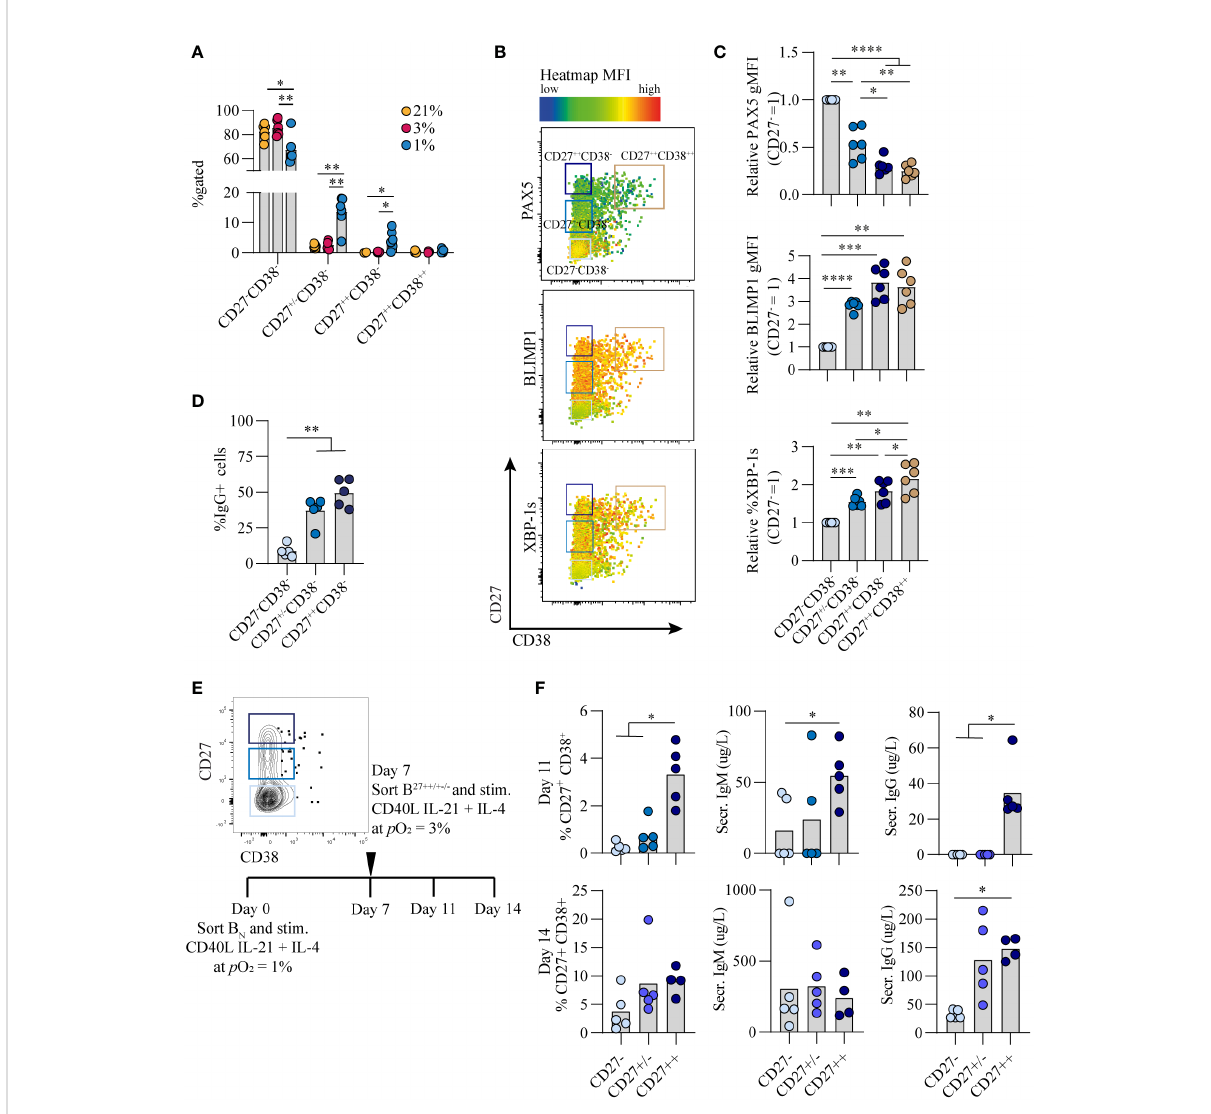
FIGURE 4 Hypoxic p O 2 drives generation of a unique CD27 ++ B cell population, with enhanced antibody secreting cell differentiation capacity and Ig production upon restimulation (A) Quanti fi cation of percentage of CD27 - CD38 - , CD27 +/- CD38 - , CD27 ++ CD38 - and CD27 ++ CD38 ++ cells on day 7 of culture ( n = 5) (B) Representative biaxial fl ow cytometry plot of CD27 and CD38 expression, with heatmap depicting MFI expression of PAX5, BLIMP1 and XBP-1s on day 7. (C) gMFI of PAX5, BLIMP1 and XBP-1s in respective populations of CD27 - CD38 - , CD27 +/- CD38 - , CD27 ++ CD38 - and CD27 ++ CD38 ++ cells on day 7 ( n = 6) (D) Percentage of IgG+ B cells on day 7 of of culture at 1% pO 2 within CD27 ++ CD38 - , CD27 +/- CD38 - or CD27 - CD38 - populations. ( n = 5) (E) Representative example of FACS sort gating strategy on day 7 to isolate CD27 ++ CD38 - , CD27 +/- CD38 - or CD27 - CD38 - B cells with schematic experimental time line. (F) Quanti fi cation of %CD27 + CD38 + cells by fl ow cytometry and IgG and IgM secretion by ELISA, 4 or 7 days after sort (day 11 or 14 of culture) ( n = 5). (A-F) Bars represent means of biological replicates each composed of two technical replicates of (A, C, D) 2 or (F) 1 independent experiment (A) Differences in %gated cells were determined using mixed-effects analysis using Tukey ’ s test for multiple comparisons. (C, D, F) Differences in gMFI and % gated cells were determined using repeated measures one-way ANOVA using Tukey ’ s test for multiple comparisons. *p < 0.05, **p < 0.01, ***p < 0.001, ****p <